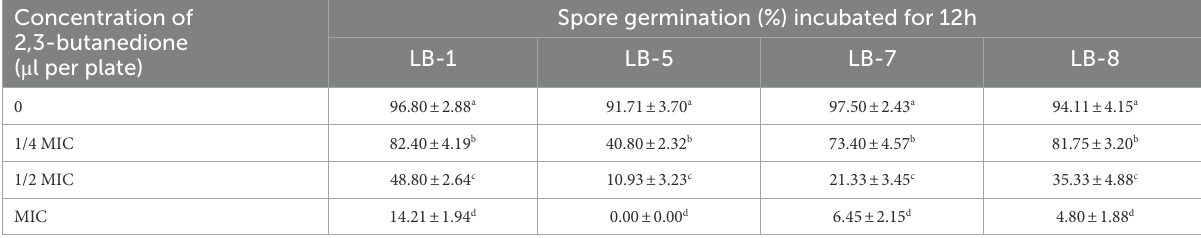
TABLE 2 Effects of 2,3-butanedione on the spore germination. Concentration of 2,3-butanedione